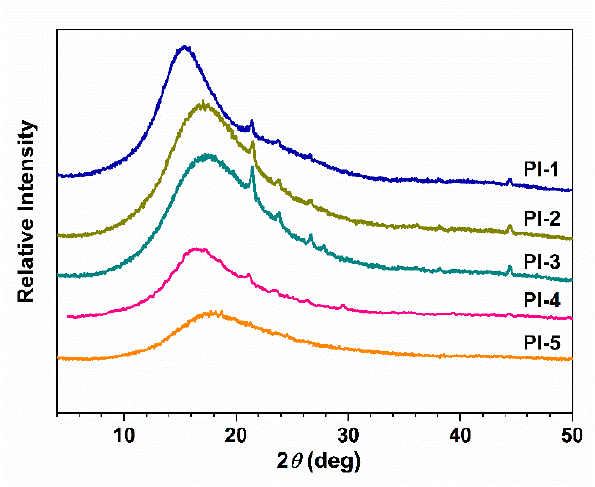
Figure 4. Wide angle X–ray diffractometry (WAXD) profiles of semi-alicyclic polyimide films.